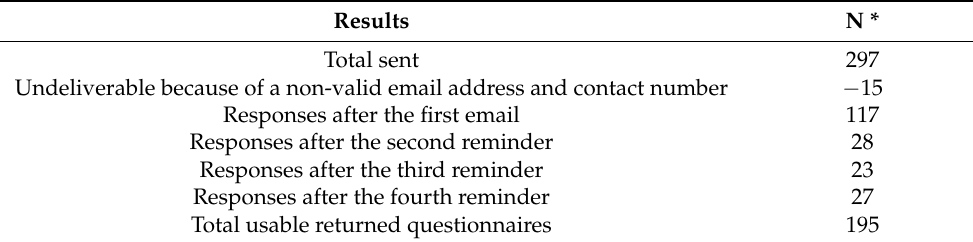
Table 2. Response rate.